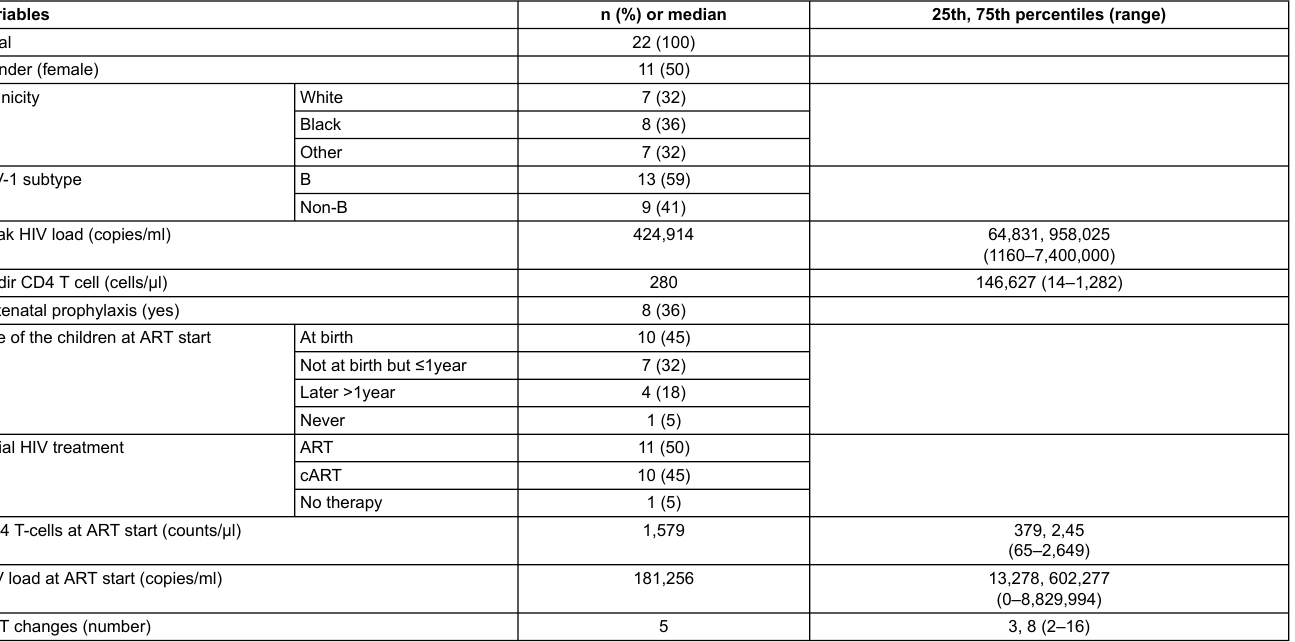
Table 2: Demographics of the HIV-infected